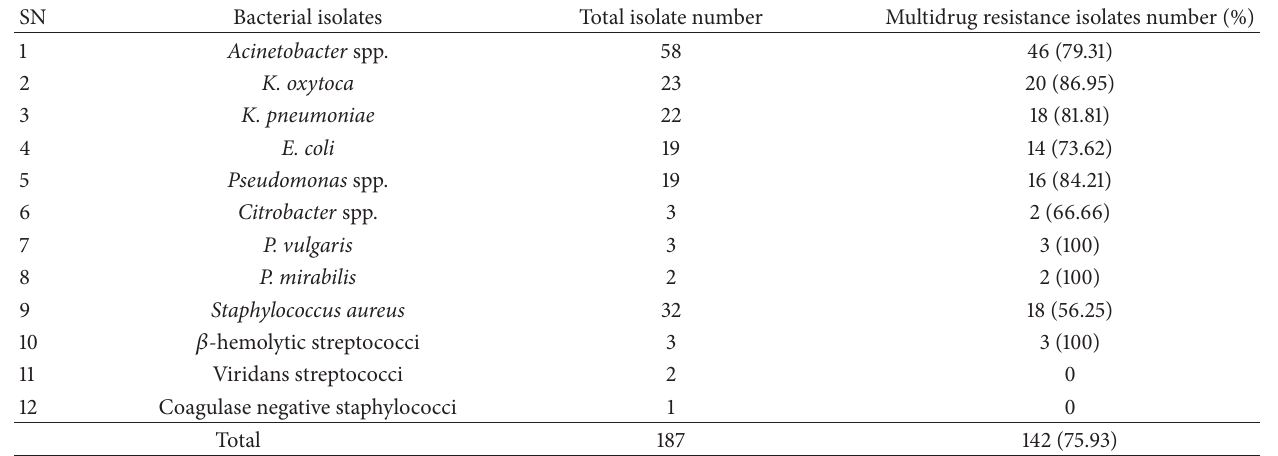
Table 2: Frequency of bacterial isolates and their multidrug resistant profile.